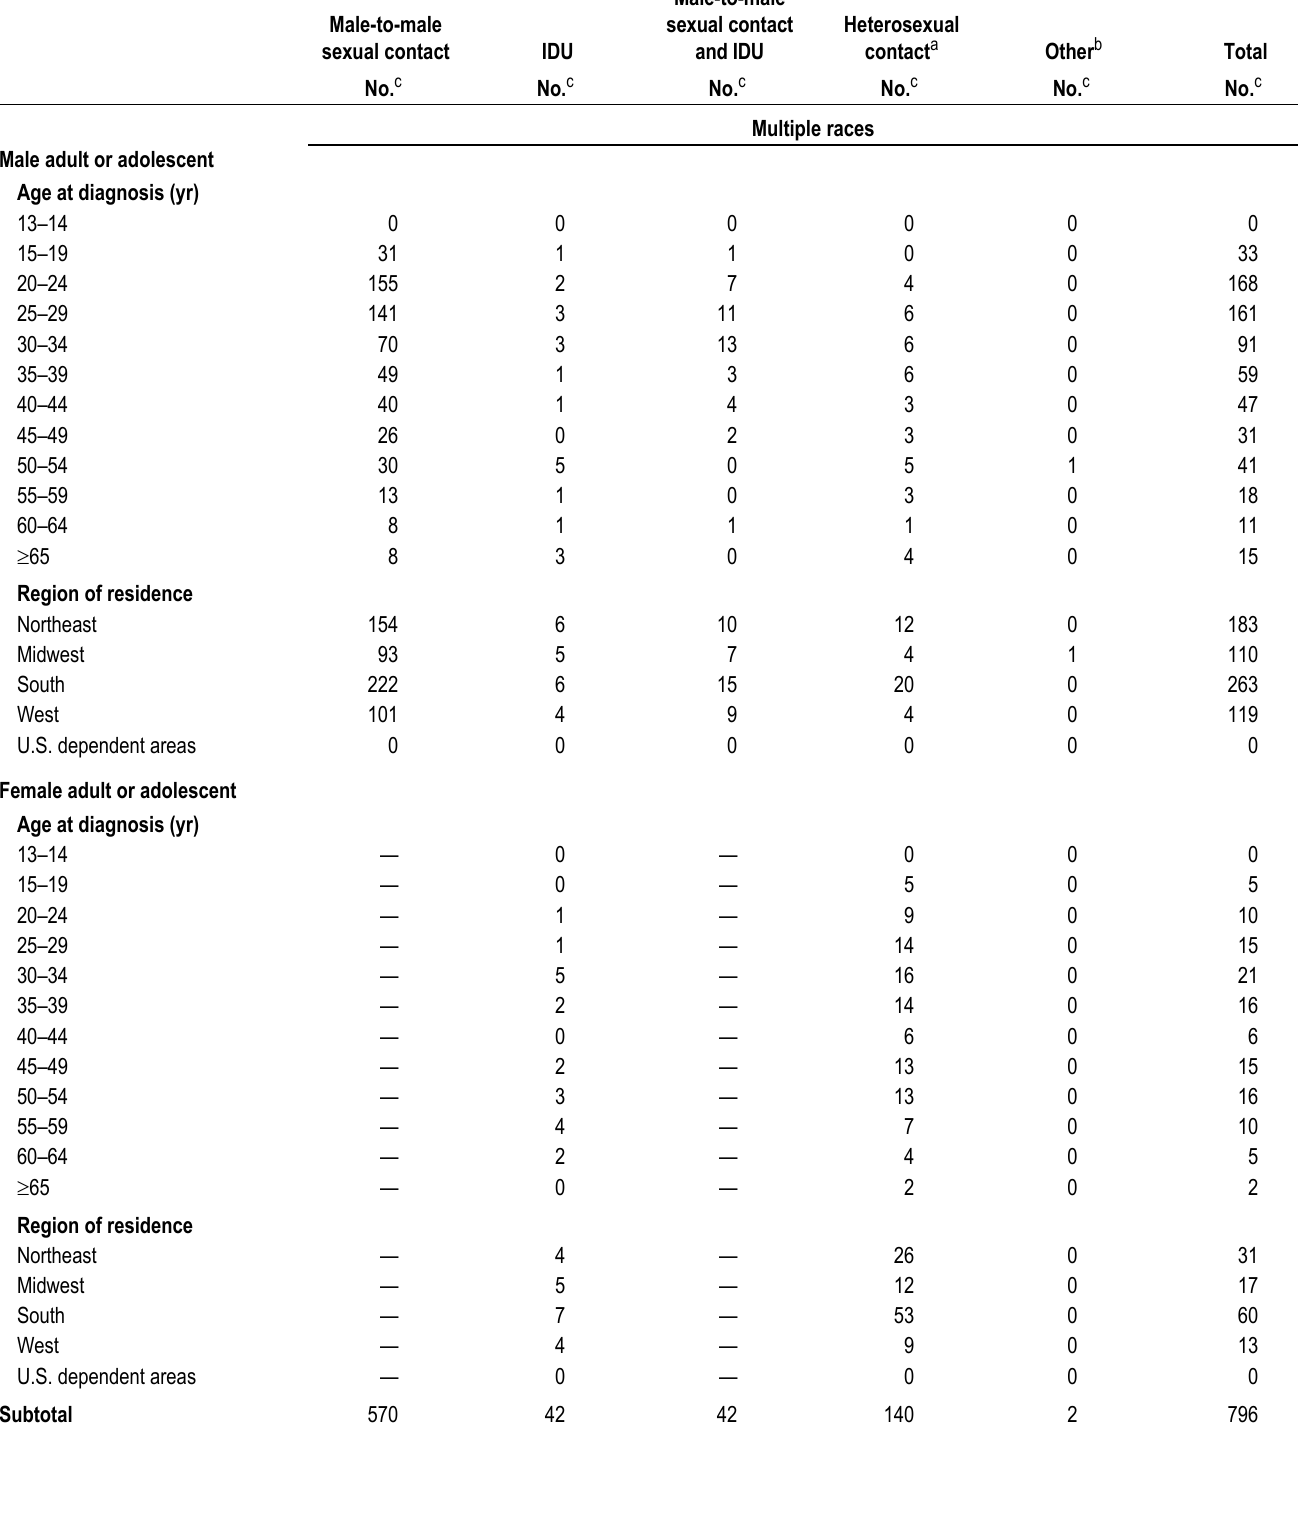
Table 5b. Diagnoses of HIV infection, by transmission category, race/ethnicity, and selected characteristics, 2015—United States and 6 dependent areas